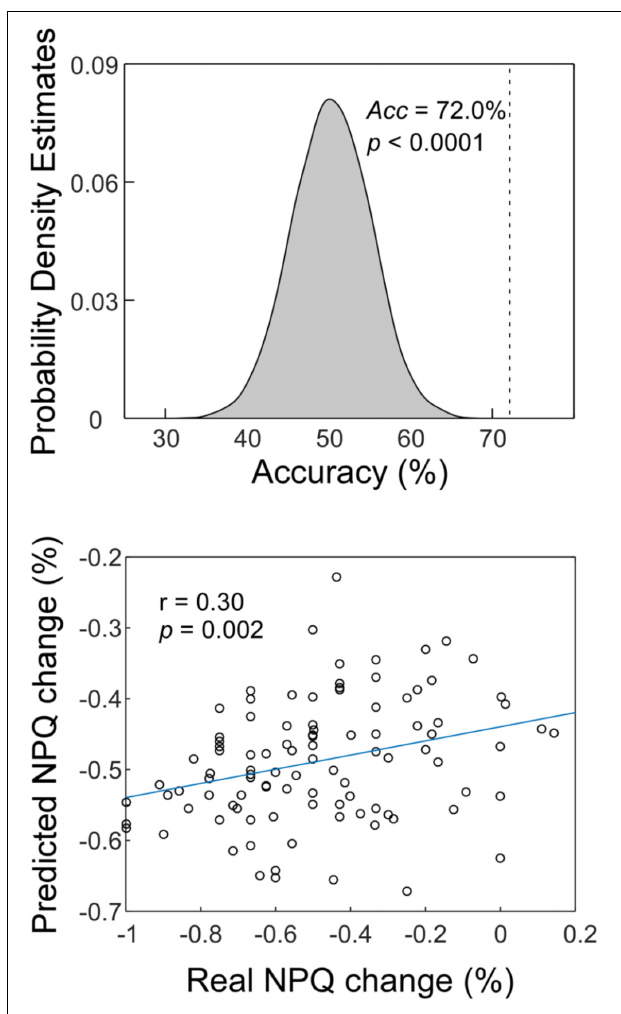
FIGURE 2 | The MVPA results. Upper panel : The classification accuracy of discriminating CSNP patients and HCs. Lower panel : The prediction-outcome correlation of predicting treatment responses using baseline fMRI